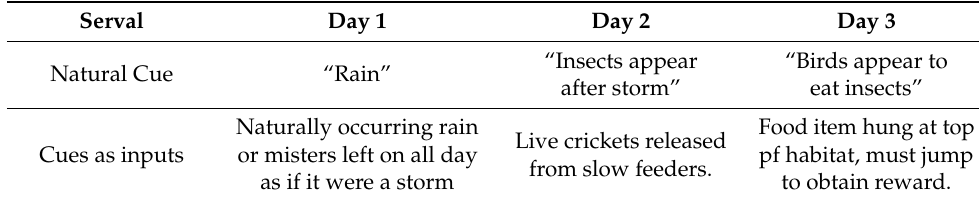
Table 2. Serval enriched event (over 3